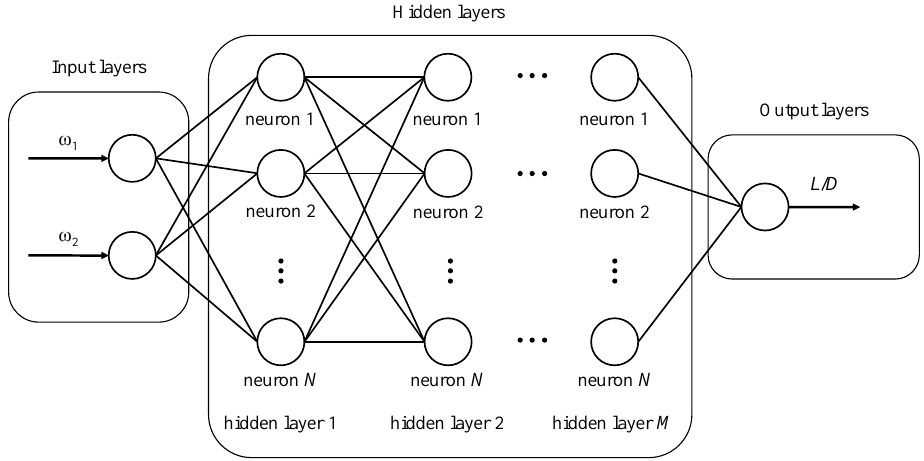
Figure 11. Structure of the constructed ANN. The number of hidden layers and neurons at each hidden layer are defined as M and N , respectively. Using the ANN, the value of the lift-to-drag ratio is predicted as a function of ω 1 and ω 2